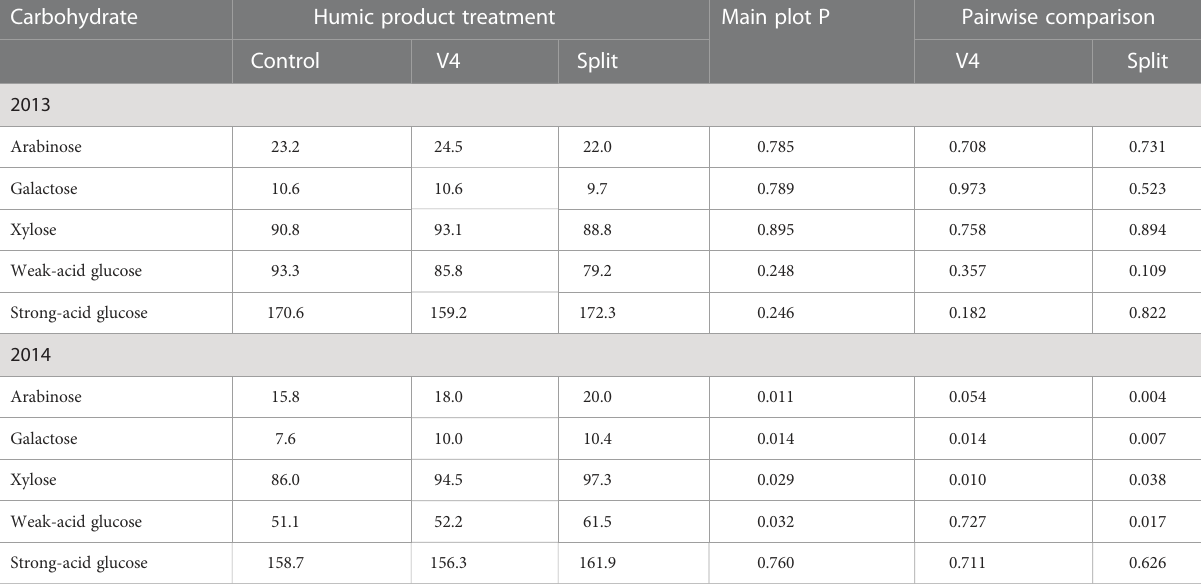
TABLE 5 Concentrations of individual carbohydrate compounds (g kg -1 ) in maize roots for the control and the V4 and split applications of the humic product in the upland transect, 2013 and 2014, together with the signi fi cance of the humic product main plot effect and the signi fi cances for pairwise comparisons of the V4 and split humic product applications with the